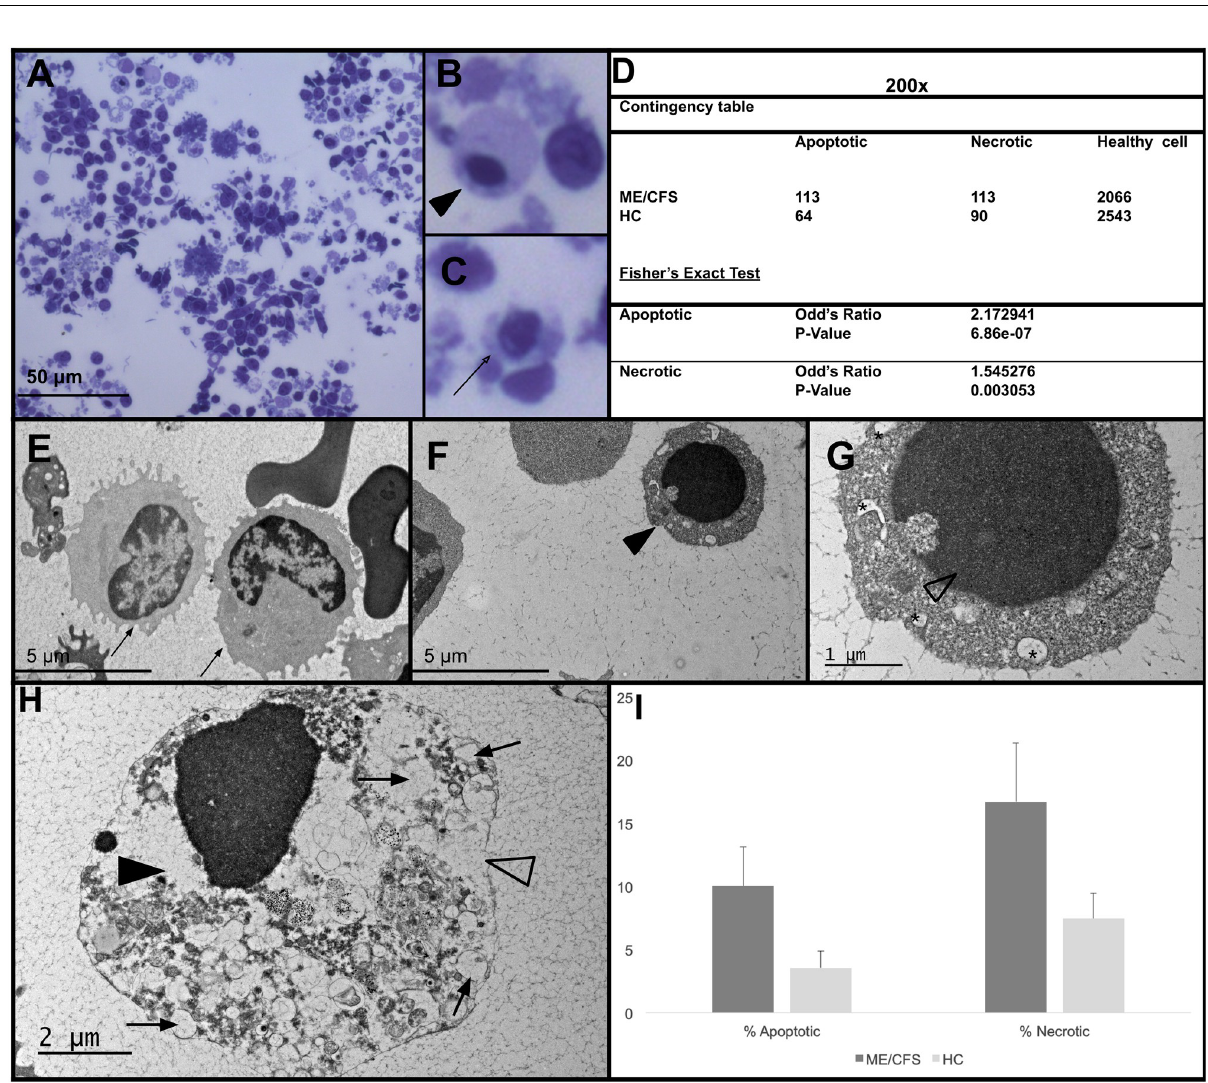
Fig 1. TEM micrographs at 200x and 1000x magnification exhibiting apoptotic and necrotic cell death in stimulated T cells. T cells were isolated and stimulated with anti-CD3/CD28 coated magnetic beads and then fixed 12h later and subjected to TEM imaging. (A) A representative TEM micrograph of stimulated T cells (T+Act) at 200x. (B) An apoptotic cell (Arrowhead) with distinct chromatin condensation. (C) A necrotic cell (Open arrow) with poorly defined edges and loss of plasma membrane integrity. (D) Contingency table showing the number of apoptotic, necrotic, and healthy cells present in the stimulated T cells of ME/CFS patients and healthy controls (HC) at 200x magnification. Fisher’s exact test shows that there is a significant increase in total apoptotic and necrotic cells in the ME/CFS cohort (p-value � 0.05). (E) A healthy T cell (arrows), with intact cell membrane and nucleus. (F, G) An apoptotic cell (arrowhead) exhibiting chromatin condensation (open arrowhead) and cytoplasmic shrinkage. (H) A necrotic cell displaying electron lucent cytoplasm (arrowhead), loss of plasma membrane integrity (open arrowhead) and increase in vacuolization (arrow). (I) Percentage of apoptotic and necrotic cells in ME/CFS subjects and healthy controls. TEM micrographs were scored, apoptotic and necrotic cells were counted and expressed as a mean percentage of cells. Magnification was between 500x and 1500x.